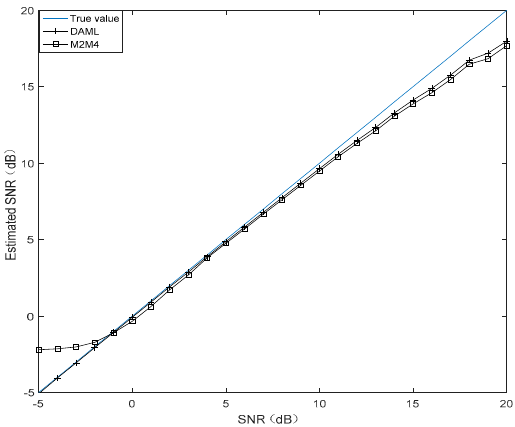
Figure 3. Estimated SNR comparison of DA ML and M 2 M 4 in Ka-band fading channel.